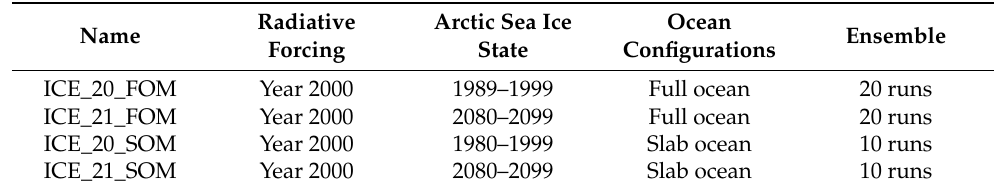
Table 1. Design of the model experiments. The results use the ensemble mean of the runs. Each run